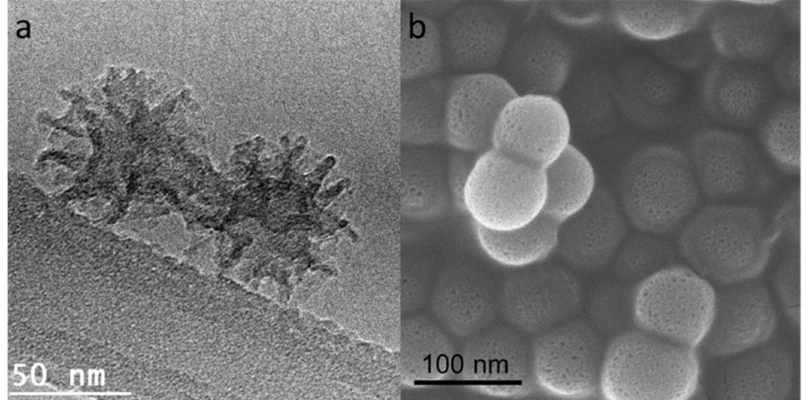
Figure 2. ( a ) Transmission electron microscopy (TEM) and ( b ) scanning electron microscopy (SEM) images of biphenyl wrinkled